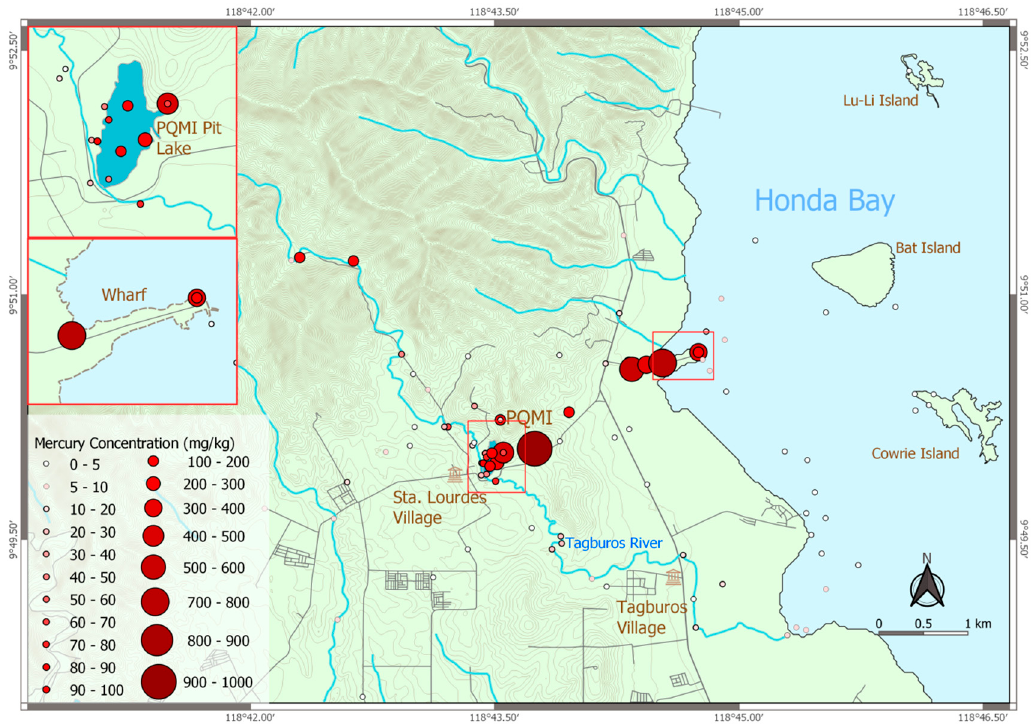
Figure 3. Map showing the total Hg concentration in soils and sediments in the study area.